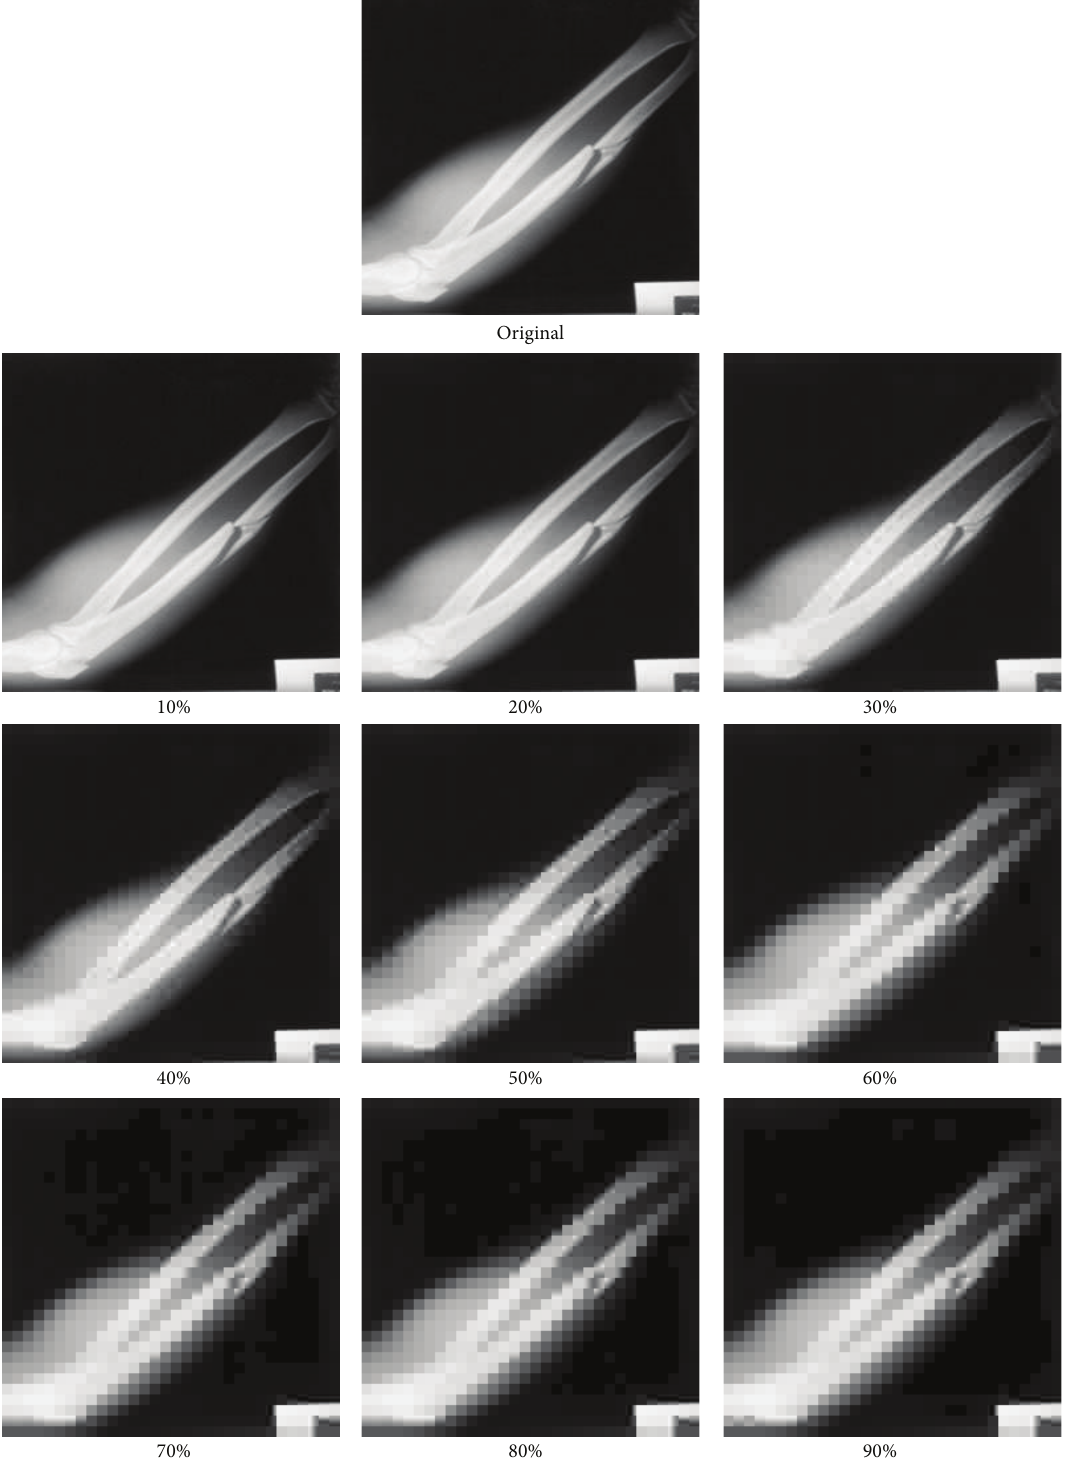
Figure 2: An original image, its DCT compression at nine